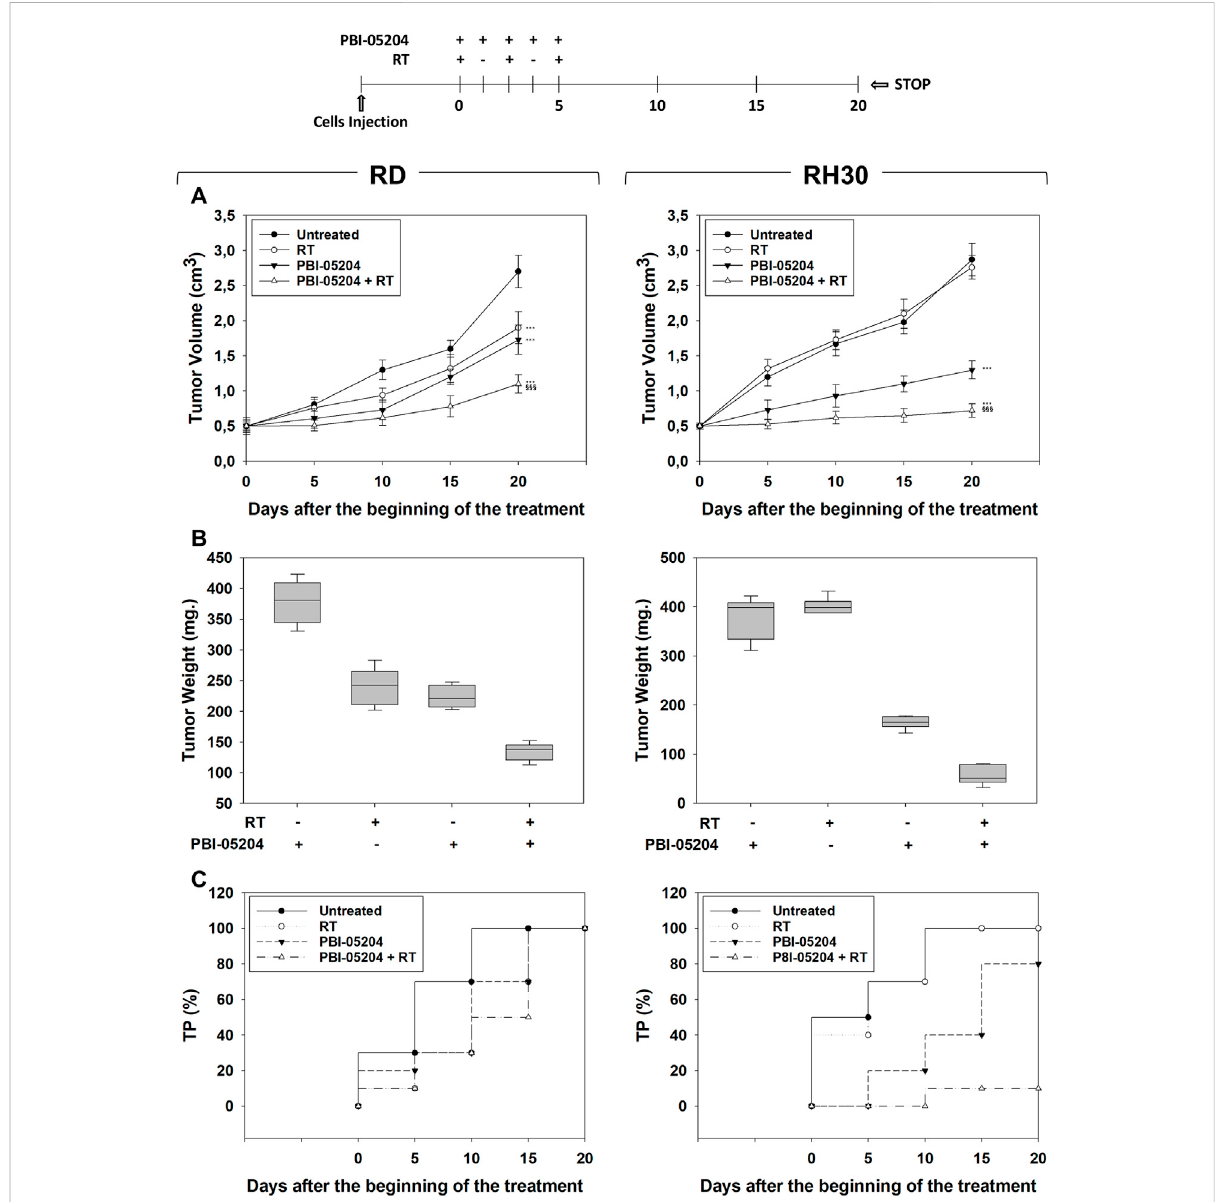
FIGURE 7 Effect of PBI-05204 combined or not with irradiation on in vivo tumor growth. The diagram above all the fi gures indicates the experiment procedure. (A) GrowthcurveoftumorvolumesfromxenograftedRDandRH30celllines,untreated,PBI-05204-treated,irradiated(RT),PBI-05204- pre-treated and irradiated (RT + PBI-05204). Tumor volumes were evaluated as described in methods and represent the mean ± SEM of eight mice per group. The graphs show the sequential treatments of xenografted mice started when tumors reached an initial volume of approximately 0.5 cm 3 . Results represent the mean values ±SD. Statistical signi fi cance: ** p ≤ 0.01, *** p ≤ 0.001 vs. Untreated mice; $$$ p ≤ 0.001 vs. RT-treated mice;### p ≤ 0.001 vs.PBI-05204-treatedmice. (B) Tumorweights frommice injectedwith RD(Left)and RH30(Right) andtreatedwith PBI-05204 and RT alone or in combination. (C) Kaplan – Meier estimates for rates of progression for untreated, PBI-05204, RT, or PBI-05204 + RT combination in RMS-derived